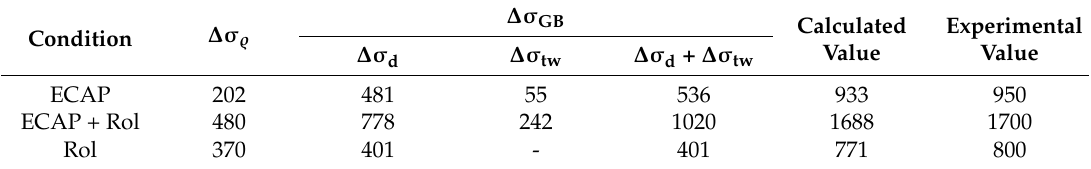
Table 4. Calculated results for the contribution of different mechanisms to the strengthening of the steel.